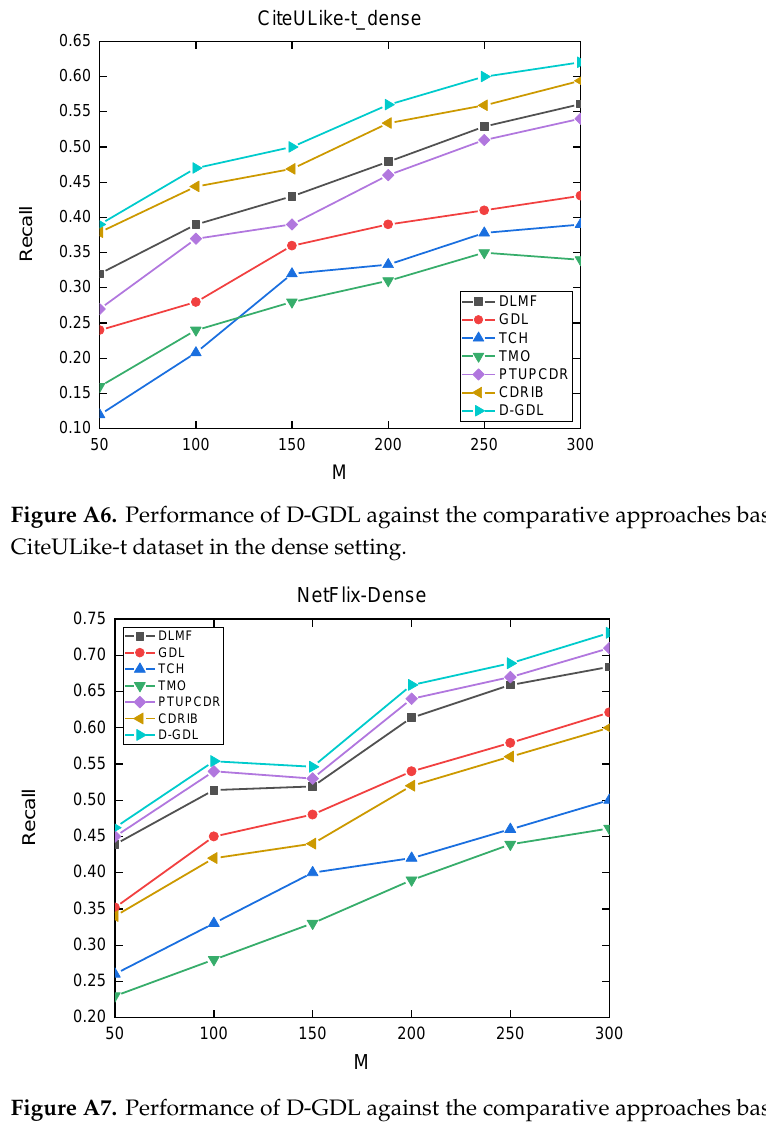
Figure A8. Performance of D-GDL against the comparative approaches based on Recall vs. M for Flixster dataset in the dense setting.